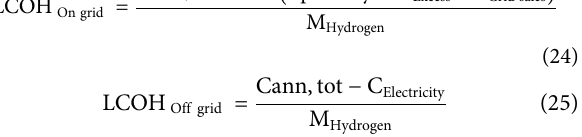
Frontiers in Energy Research |